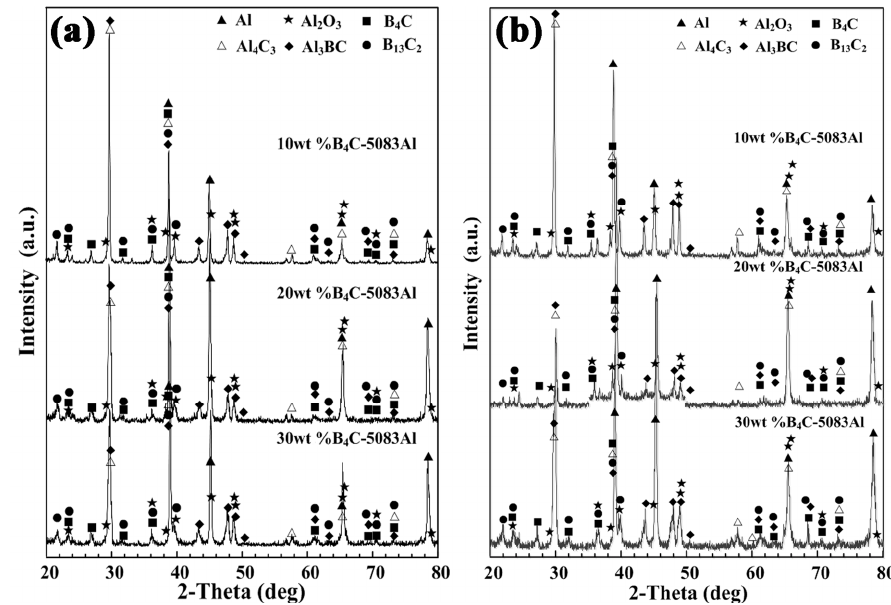
Figure 5. Phase identification of ( a ) bionic Meretrix lusoria shell and ( b ) Rapana venosa shell layered composite materials.